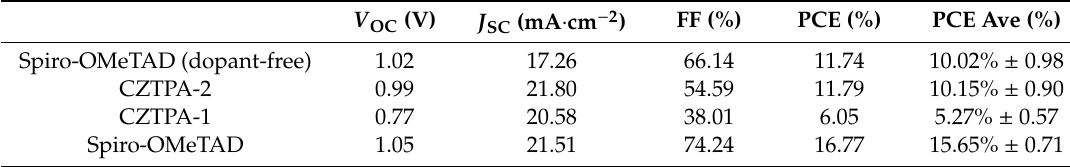
Table 2. Photovoltaic data of PSCs based on the two HTMs, the Spiro-OMeTAD, and the Spiro-OMeTAD (dopant-free).